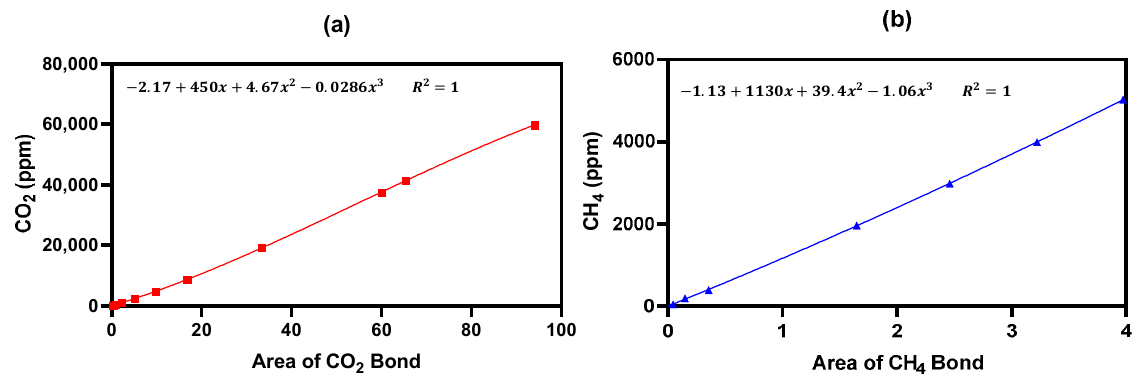
Figure 4. The calibration curve of CO 2 ( a ) shows a polynomial fitting of the CO 2 calibration curve on FTIR ranging from 101 ppm to 59,806 ppm. As for the CH 4 ( b ), the highest concentration that was applied was 5000 ± 99 ppm, with an average absorbance area (Abs) of 3.97 ± 0.012. The lowest concentration tested was 50 ppm, with an average absorbance area of 0.046 ± 0.024 (resolution: 1 cm − 1 ).